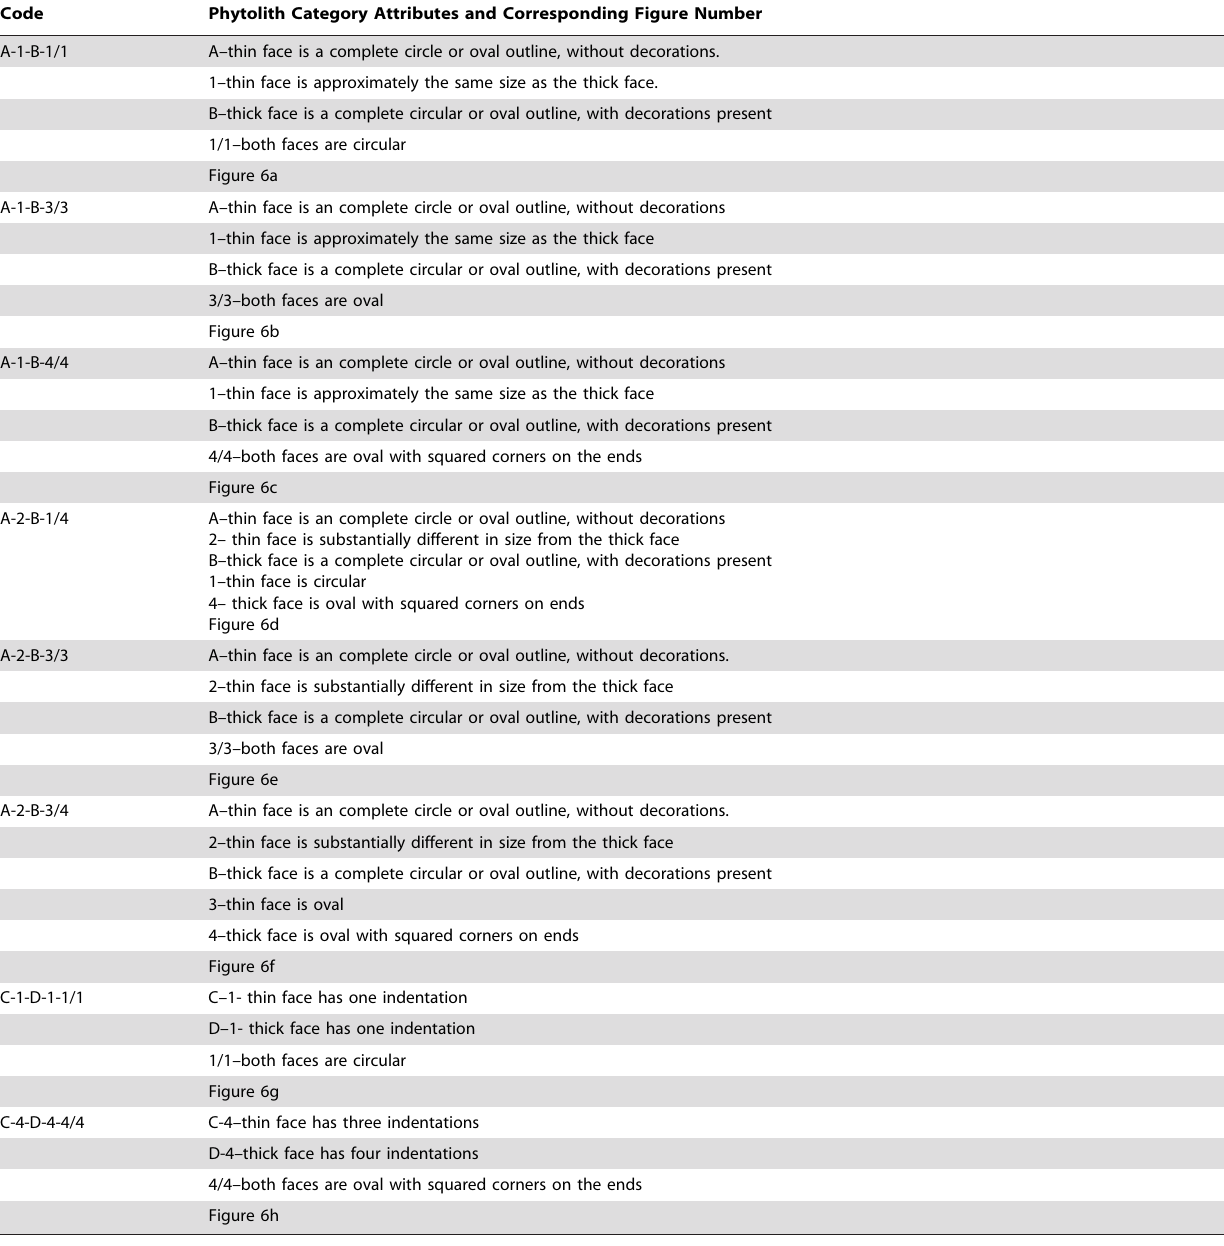
Table 5. Descriptions of important discriminating rondel phytolith categories mentioned in